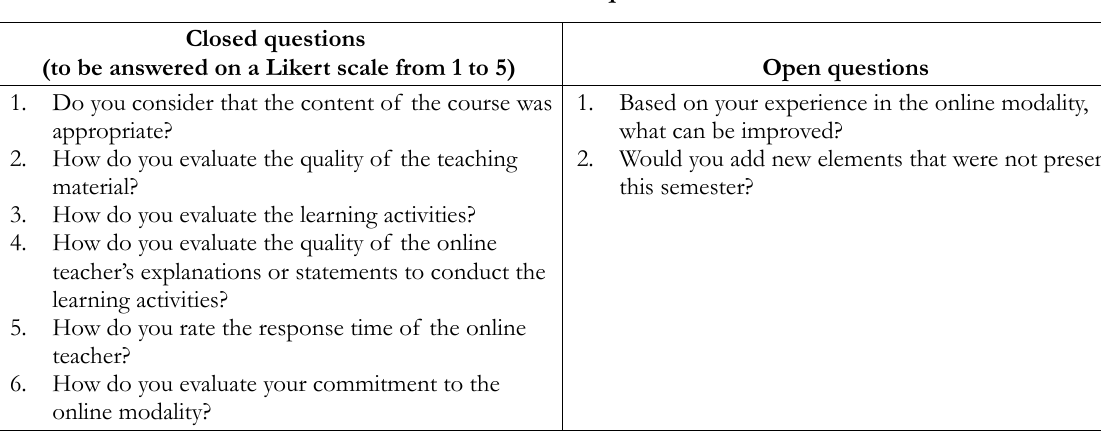
Table 6. List of closed and open questions on the student satisfaction questionnaire administered within the